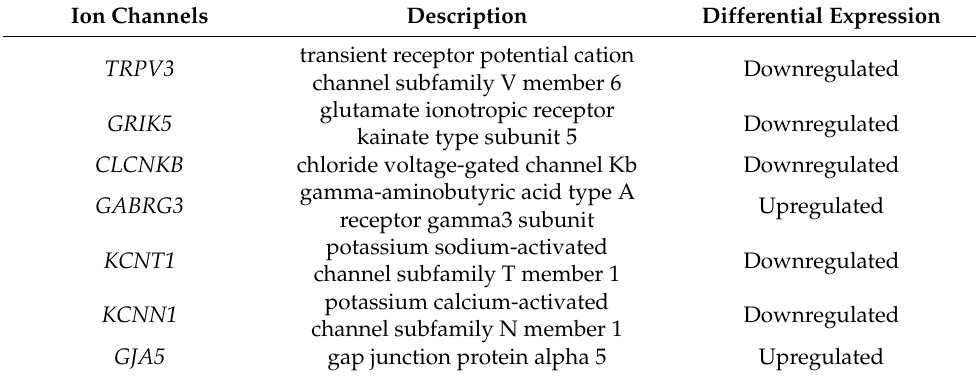
Table 3. A partial list of differentially expressed ion channels in TM state in breast